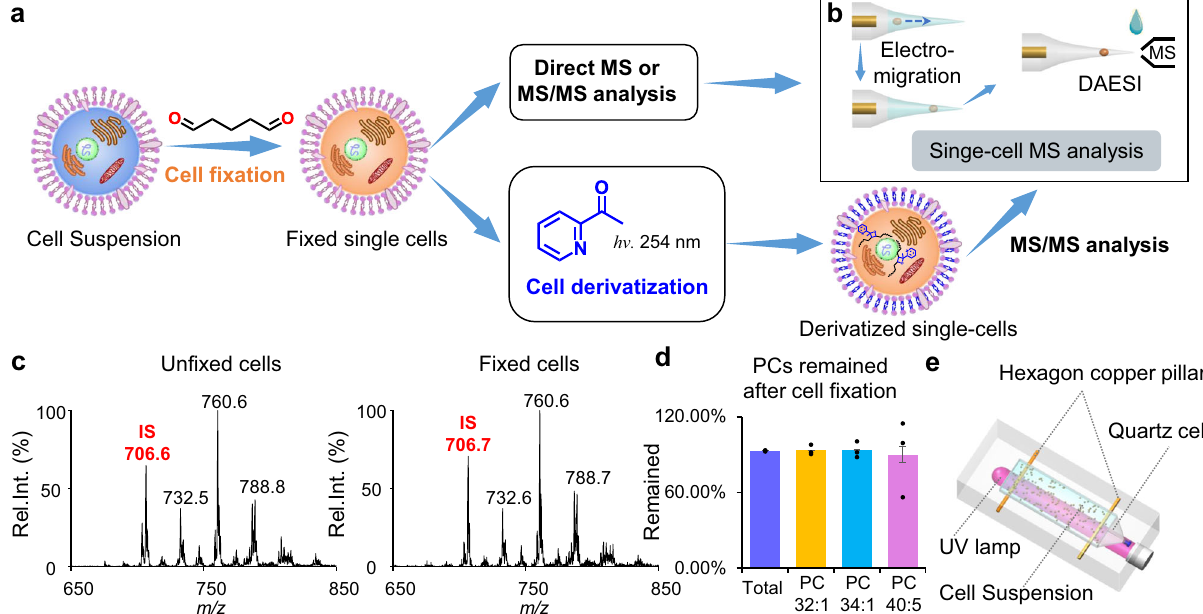
Fig. 1 Work fl ow of single-cell lipidomics with high structural speci fi city. a Work fl ow of single-cell fi xation and optional derivatization for subsequent MS analysis. b Work fl ow of single-cell MS analysis method that allowed multi-round sampling and data acquisition. DAESI: droplet-assisted electrospray ionization. c Precursor ion scan of m/z 184 spectrum of the extract of un fi xed (left) and fi xed (right) MDA-MB-231 cells. Internal standard (IS): PC 15:0- 15:0 ( m/z 706). d Remain of PCs after fi xation. Error bar represents the standard deviation, n = 3. e Experimental setup of collective single cells photochemical derivatization. Source data are provided in a Source Data fi